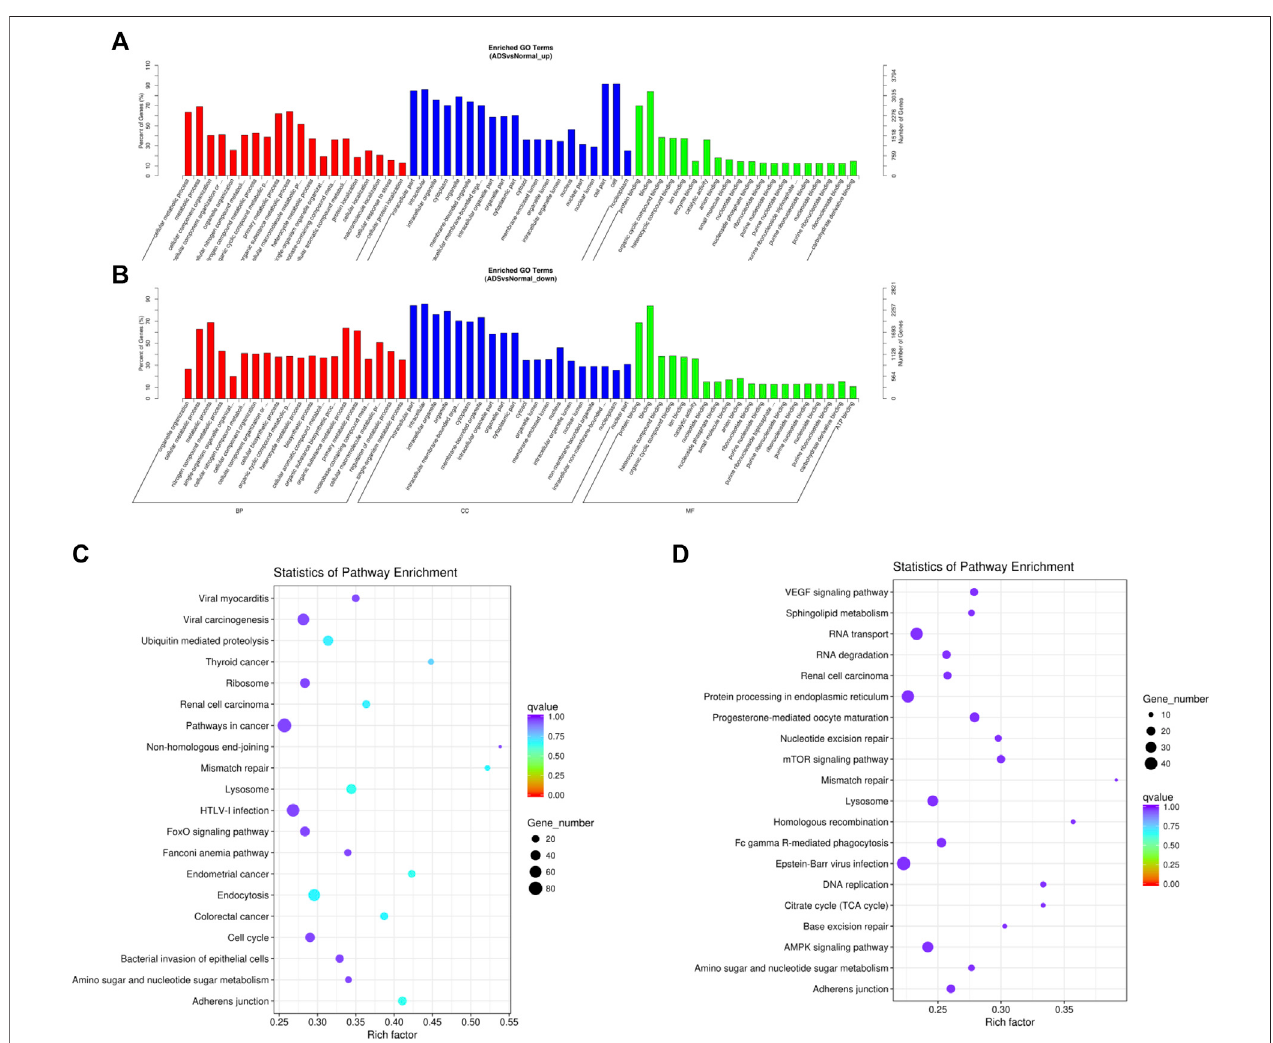
FIGURE 6 | Comparison of functional annotations of the target gene of upregulated and downregulated differentially expressed lncRNAs. The 20 most enriched Gene Ontology (GO) terms for the parental genes of (A) the upregulated differentially expressed lncRNA and (B) the downregulated differentially expressed lncRNA. (B) TwentymostenrichedKEGGpathwaysfor (C) theupregulateddifferentiallyexpressedlncRNAand (D) thedownregulateddifferentiallyexpressedlncRNA.Theenriched GO terms are on the vertical axis, and the number of annotated target genes in each GO term is indicated on the horizontal axis. The size of the symbol represents the number of genes, and the colors represent the p